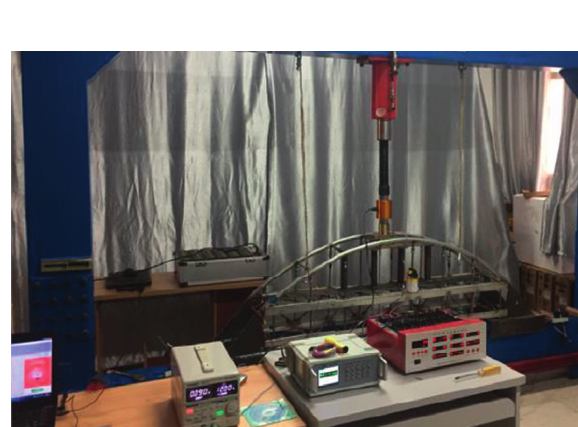
Figure 5: Model structure loading.